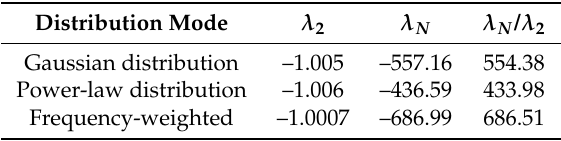
Figure 24. Synchronization progress of different weighting distributions. Table 3. Spectrum